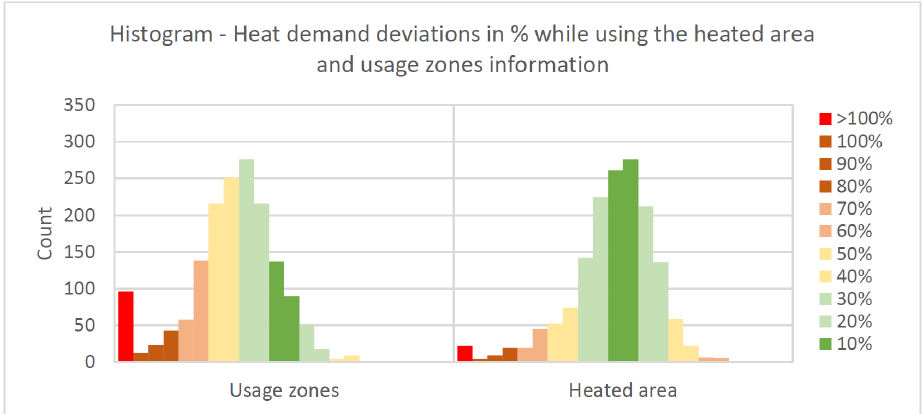
Figure 8. Distribution of deviations using the usage zone and heated area information for the